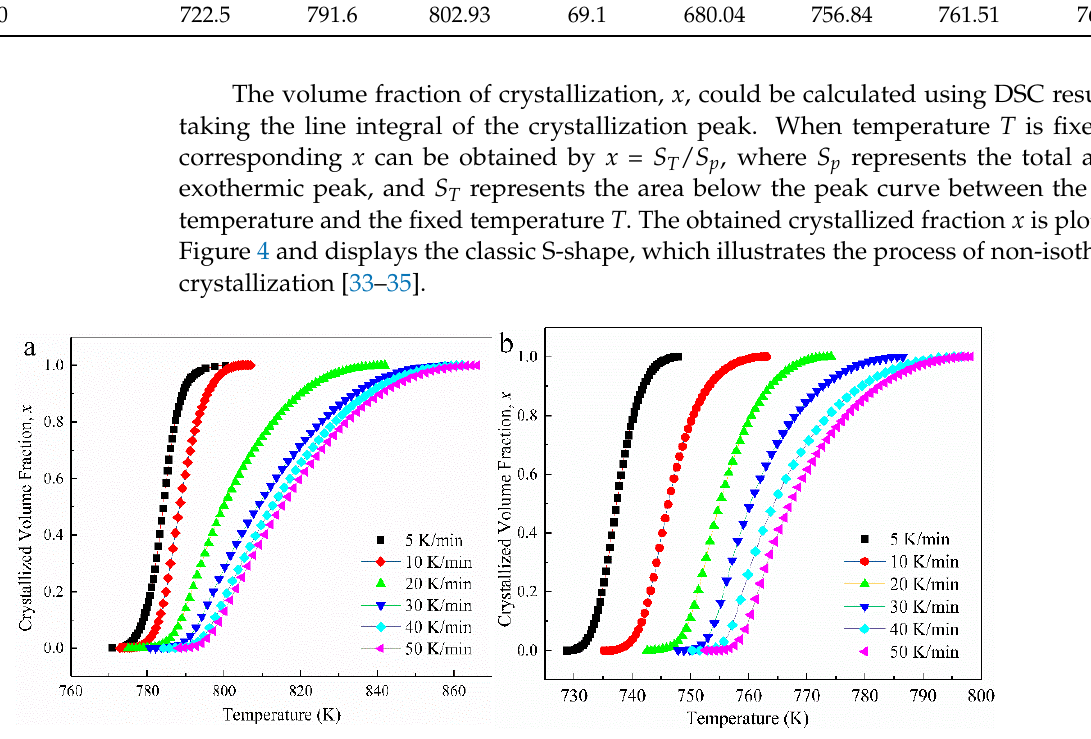
Figure 4. Crystallized fraction x corresponding temperature at different heating rates ( a ) Zr 54 BMG and ( b ) Zr 48 Ho 6 BMG.